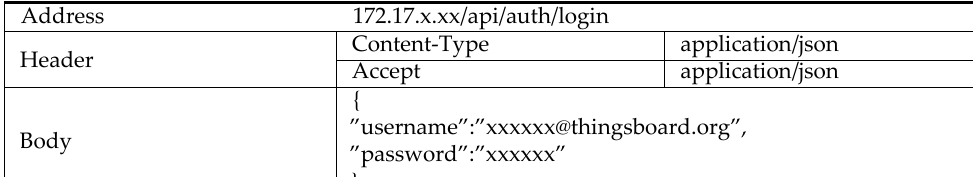
Table 4. Configuration parameters for requesting JWT token.